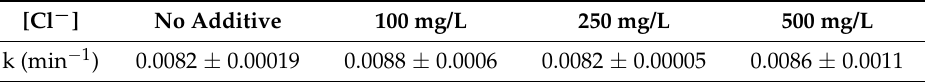
Table 3. CBZ degradation rate constants at different Cl −